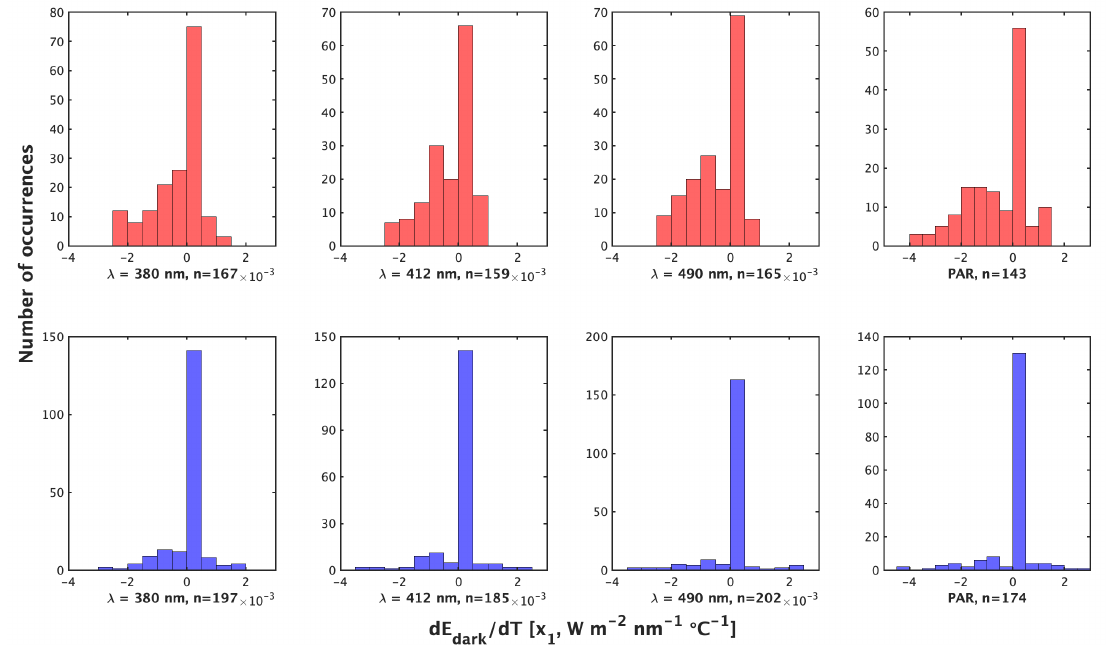
Figure 1. Histograms of the value of x 1 = dE d / dT s (W m − 2 nm − 1 ◦ C − 1 ) by the night method ( top , red) and Day method ( bottom , blue) for λ = 380 nm, 412 nm, 490 nm, and iPAR ( left to right